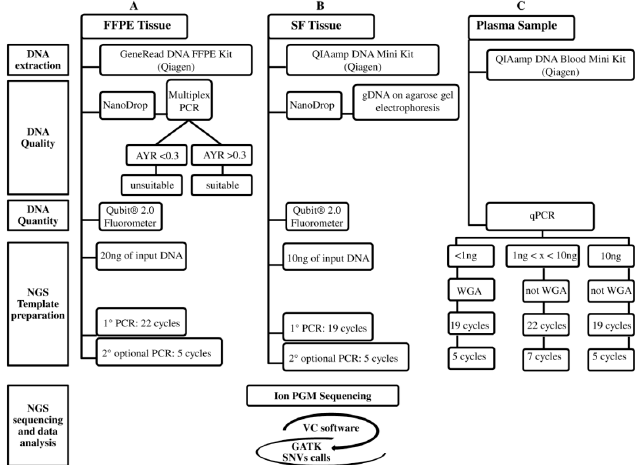
Figure 2. The three analytical NGS (Next-Generation Sequencing) workflows are: ( A ) FFPE (Formalin-Fixed Paraffin-Embedded); ( B ) SF (Snap Frozen); and ( C ) Plasma. These workflows, currently